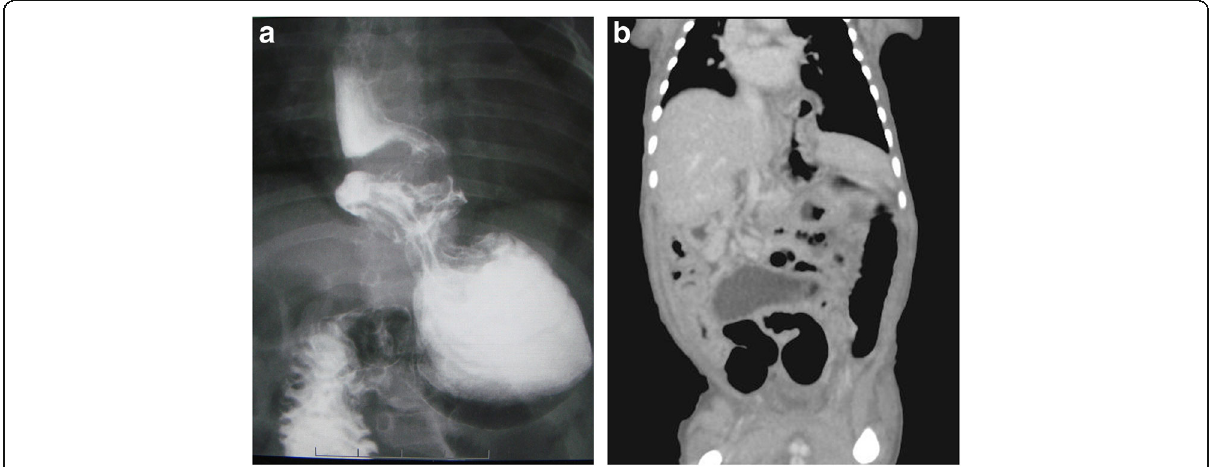
Fig. 2 a Upper gastrointestinal series on the 51st day revealed a sliding type hiatal hernia and marked GER with crooked esophagus. b